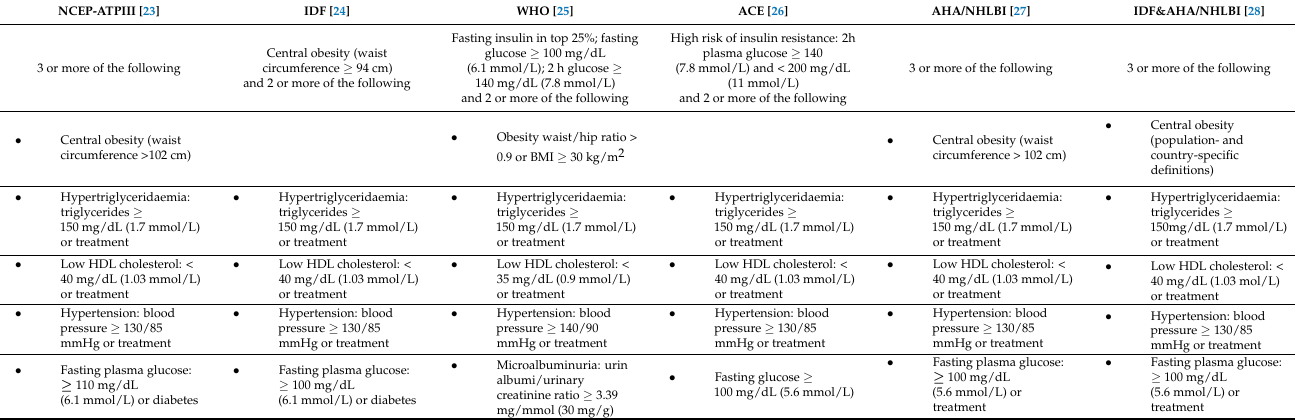
Table 1. Comparison of metabolic syndrome (MetS) definitions: National Cholesterol Education Program-Third Adult Treatment Panel (NCEP-ATPIII) and International Diabetes Federation (IDF), World Health Organization (WHO), American College of Endocrinology (ACE), American Heart Association/ National Heart, Lung and Blood Institute (AHA/NHLBI) and common definition by IDF and AHA/NHLBI